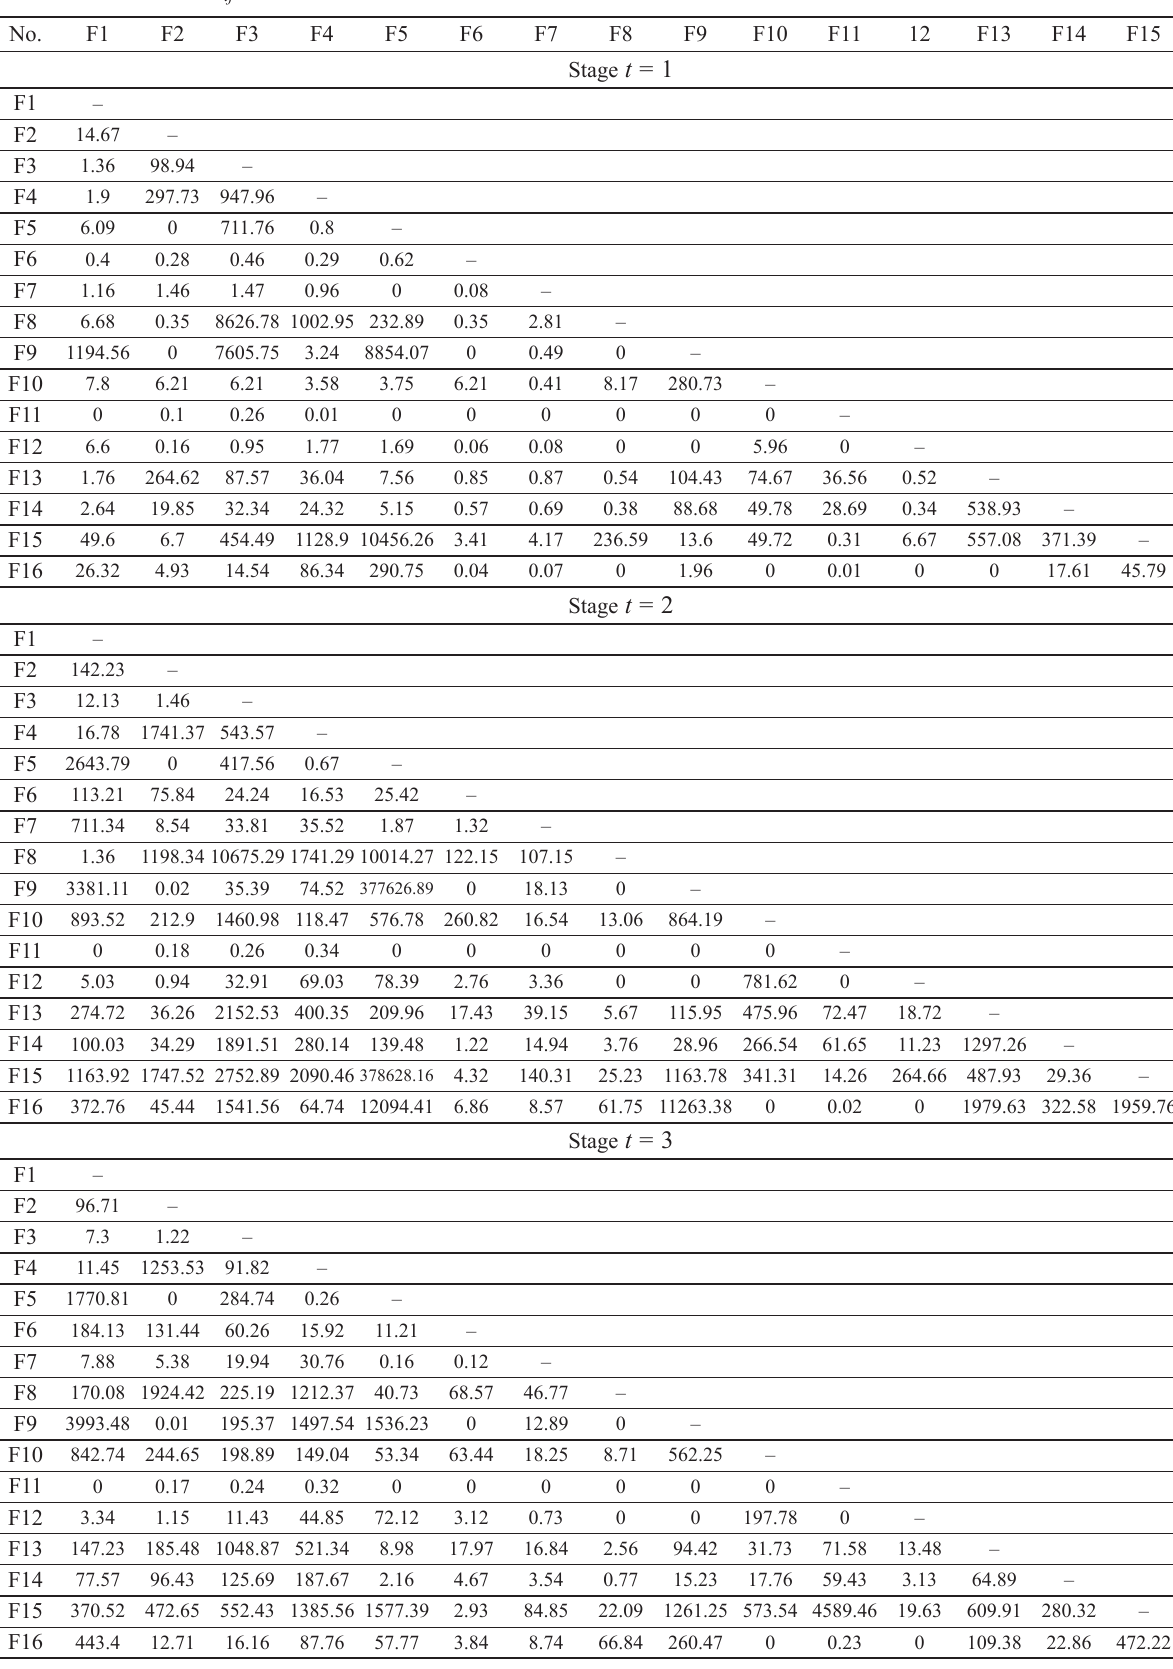
Table 3. The value flow v ij ( t ) between facilities (in 10 thousand RMB)